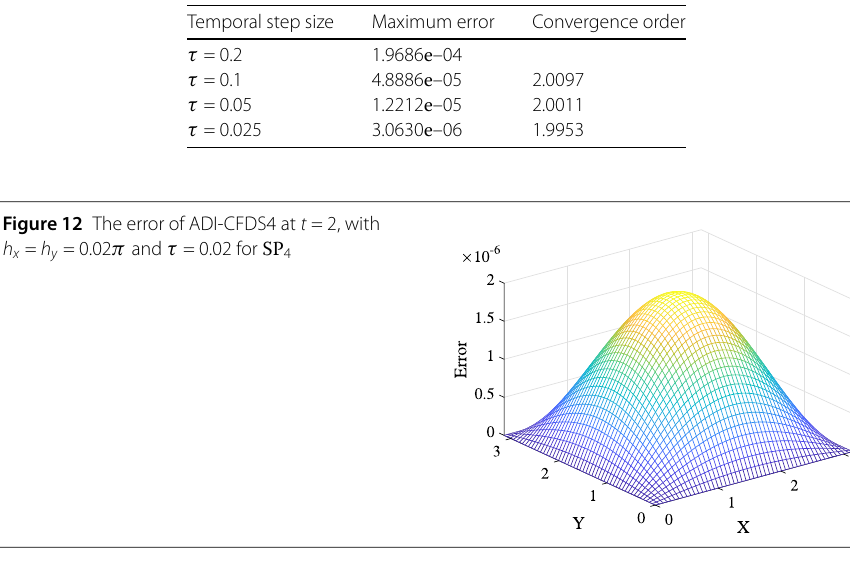
Table 20 The convergence order for R-ADI-CFDS4 at h x = h y = 0.02 π